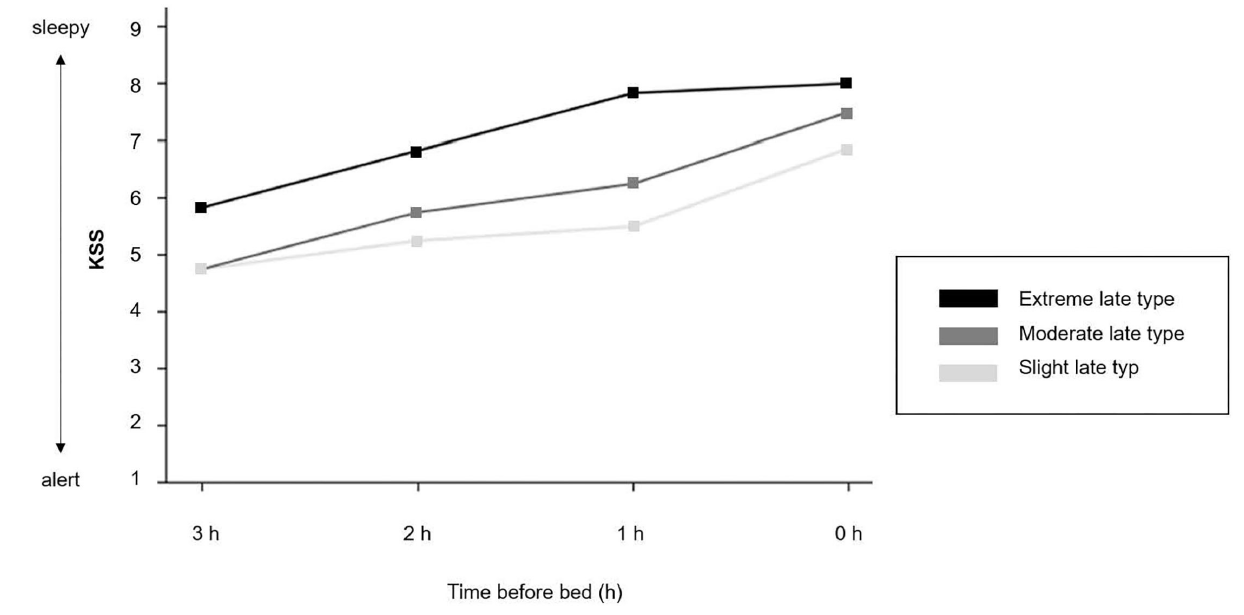
lateness was not associated with shorter sleep duration on school nights, but lower sleep quality and worse mood